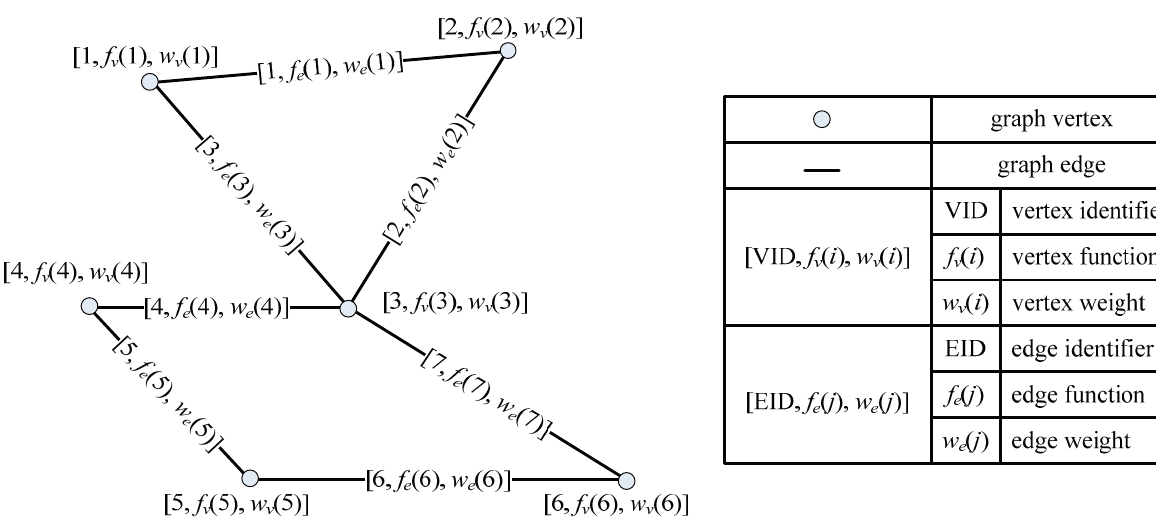
Figure 1. Graph-based representation of the spatial data dependence in spatial operations. Each graph vertex is represented as a circle with one identifier, one function and the weight, and each graph edge is represented as a line with similar